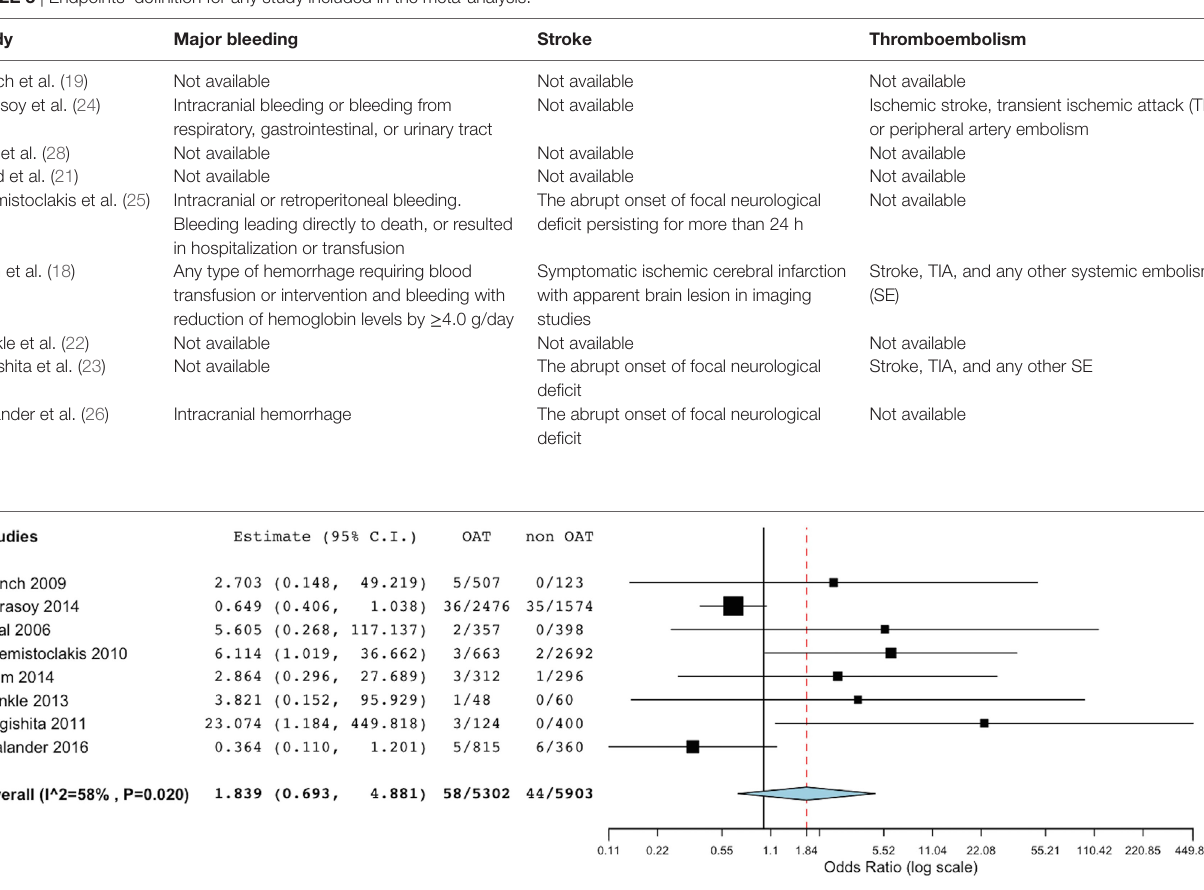
FiGUre 2 | Meta-analysis of difference in total thromboembolic events. Forest plot and summary effect of the difference in the incidence of total thromboembolic